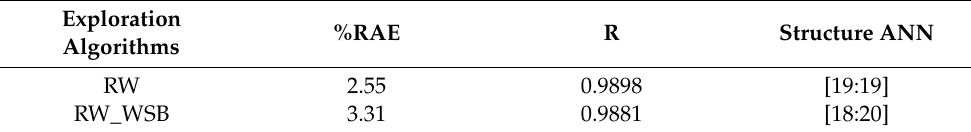
Table 2. Results for prediction of the RW and RW_WSB